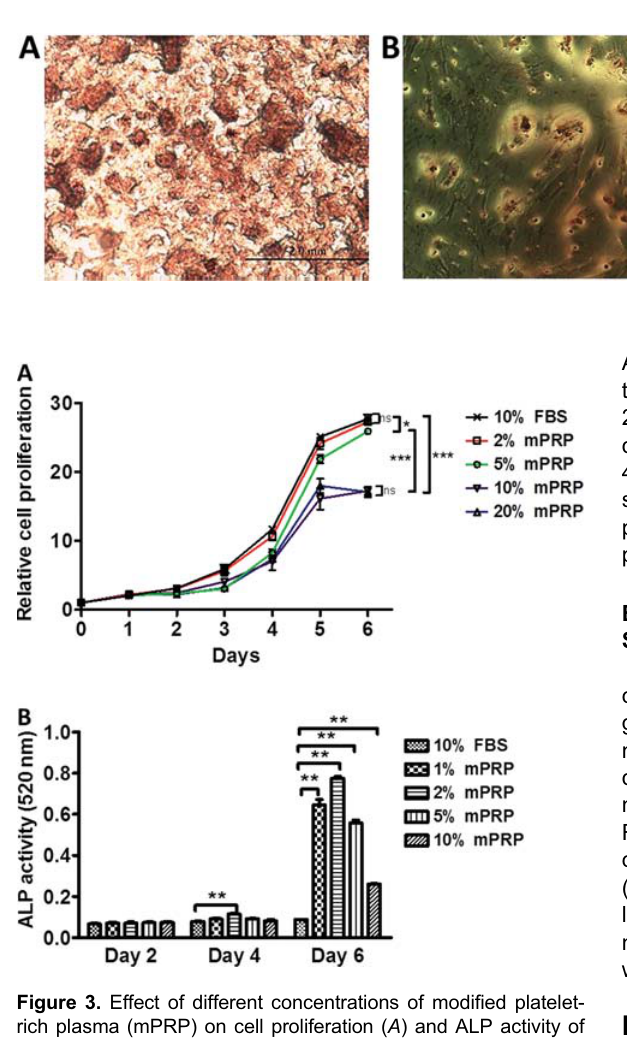
Figure 3. Effect of different concentrations of modi fi ed platelet- rich plasma (mPRP) on cell proliferation ( A ) and ALP activity of stem cells from human exfoliated deciduous teeth ( B ). Data are reported as means ± SD from three independent experiments. *P o 0.05, **P o 0.01, ***P o 0.001 vs control group (10% FBS) (Student ’ s